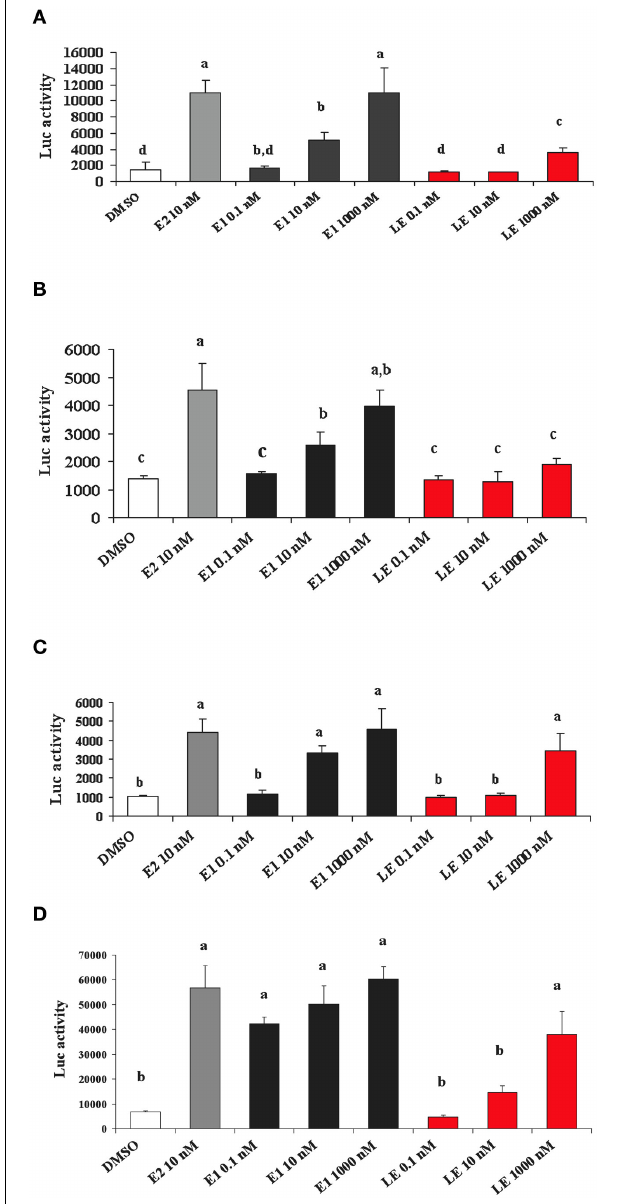
FIGURE 3 | Screening transcriptional activities of estradiol (E2), estrone (E1) and lumiestrone (LE) using estrogen receptor-dependent reporter gene assays in vitro. ER-negative U251-MG glial cells were transfected with zebrafish ER α ( (A) ), ER β 1 (B) , and ER β 2 (C) and exposed to estrogens or the dimethyl sulfoxide (DMSO) control. In (D) ER α and ER β -positive human breast cancer MCF-7 cells were used. Data are presented as mean + SEM of luciferase activity relative to β -gal ( n = 3). Data were tested for normality and homoscedasticity, and were transformed when appropriate prior to analysis by one-way ANOVA (treatment; p < 0.001) followed byTukey’s post hoc test (S-Plus, v8.0). a,b,c,d Means labeled with different superscripts are significantly different ( p <